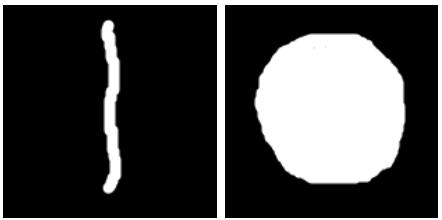
Figure 4. The two simplest dust types considered for the dusts classification: filiform and circular shapes.